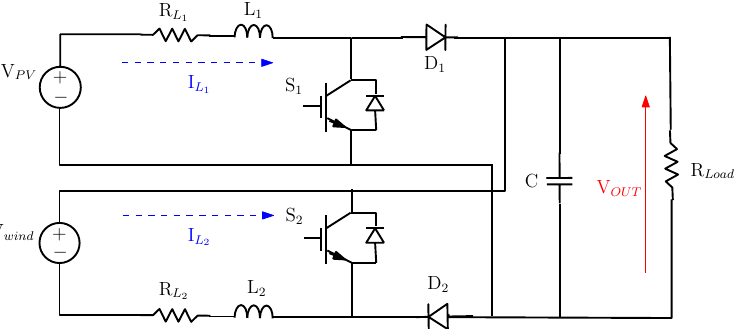
Figure 3. Boost–boost converter circuit